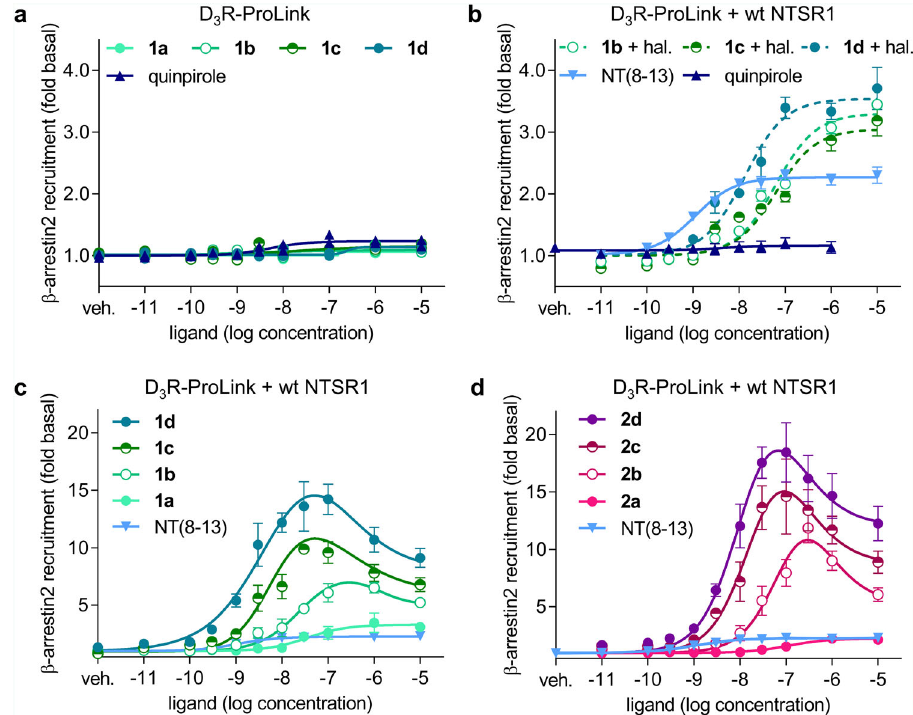
Fig. 6 β -arrestin2 recruitment to D 3 R mono- and D 3 R-NTSR1 coexpressing HEK293 cells indicates a speci fi c effect of the bivalent ligands. The DiscoverX enzyme fragment complementation assay allows detection of β -arrestin2 recruitment to a GPCR that is C-terminally tagged with the ProLink fragment. a No β -arrestin2 recruitment to D 3 R-ProLink was detected after stimulation with quinpirole or compounds 1a - d (individual data points, n = 2 independent experiments). b Coexpression of wild-type NTSR1 does not alter β -arrestin2 recruitment to D 3 R-Prolink upon stimulation with quinpirole ( n = 3). NT(8-13) induces a concentration dependent response (EC 50 1.5 ± 0.4 nM, n = 8). c , d Stimulation with type 1 and 2 bivalent ligands results in bell- shaped concentration-response curves in D 3 R-ProLink-NTSR1 coexpressing cells ( n = 4 for 1a - c , 2b and n = 3 for 1d , 2a , c , d ). b Prevention of the bivalent binding mode by high concentrations of haloperidol (1 µ M, 30 min preincubation, n = 3) reduces β -arrestin2 recruitment close to the level of NT(8-13) alone. Error bars denote s.e.m. of n independent